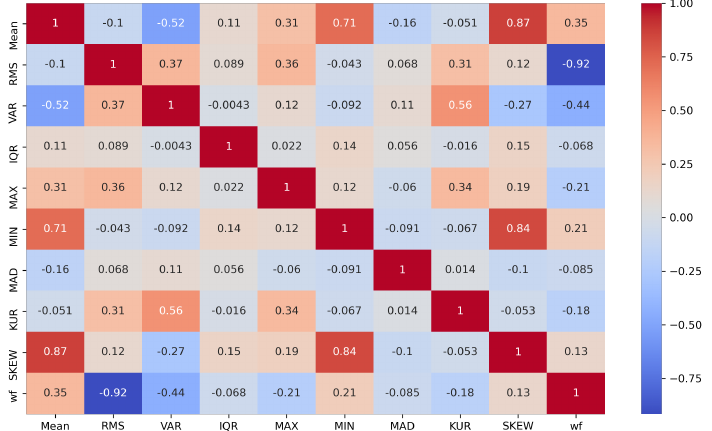
Figure 11. Feature selection plot for the ESR dataset.